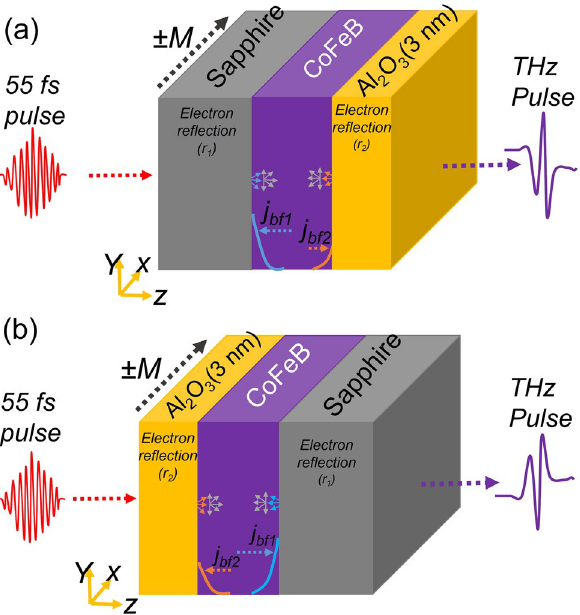
Figure 1. Schematic of THz emission from the AHE-based CoFeB emitter. ( a ) Pumping from the substrate side and ( b ) pumping from capping side. j bf 1 ( 2 ) and r 1 ( 2 ) represent the backflow currents and electron reflection coefficients, respectively, at the interface. Here, 1 and 2 correspond to the substrate/CoFeB and CoFeB/capping interfaces,